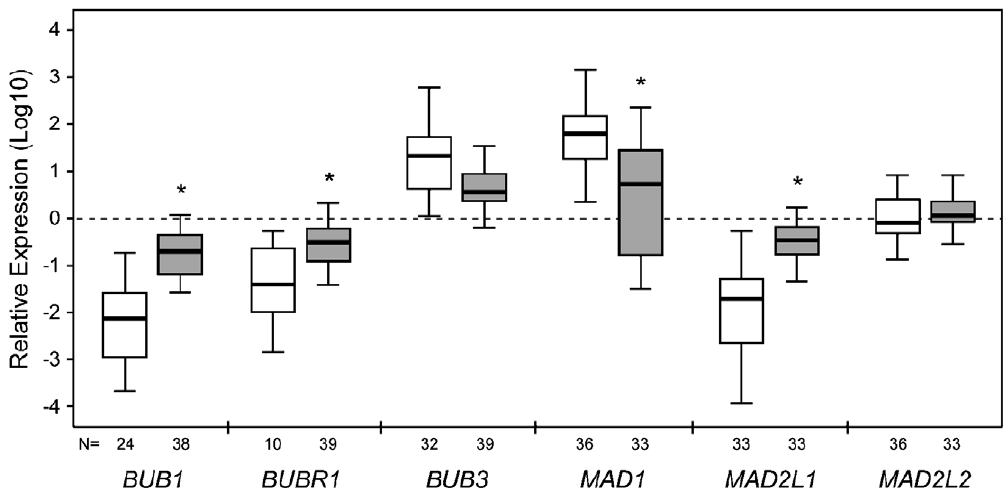
Fig. 1. Distribution of the relative expression levels in normal tissue (white box-plots) and ccRCC (shaded box-plots) for the six genes assessed in this study. ∗ Statistically significant differences between tumor samples and normal controls ( BUB1 , p < 0 . 001; BUBR1 , p = 0 . 003; MAD1 , p < 0 . 001; MAD2L2 , p < 0 .